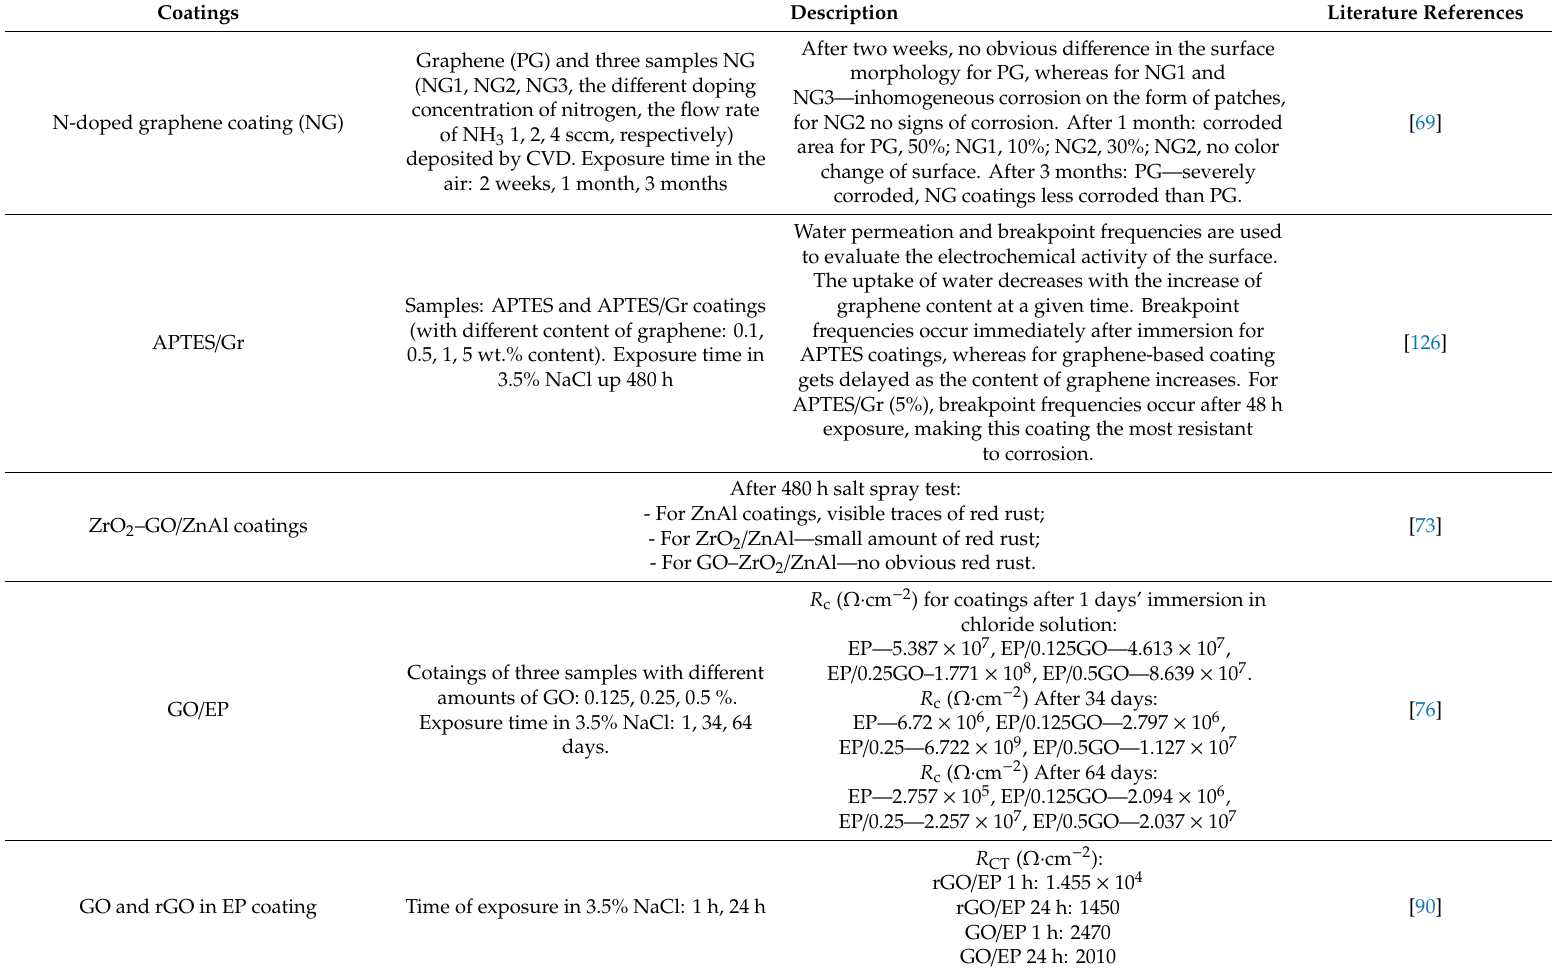
Table 5. Comparison of long-term anticorrosion properties between di ff erent